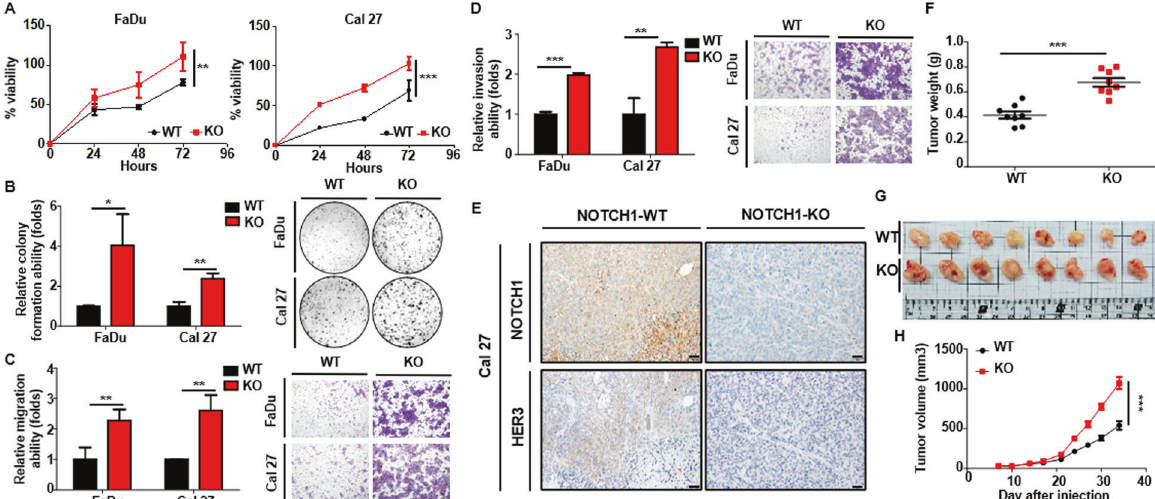
Fig. 4 Loss of function of NOTCH1 down-regulates HER3 expression and augments tumor aggressiveness in SCCHN. Functional assays were performed and a comparison between the NOTCH1-wild type (WT) and NOTCH1-knockout (KO) SCCHN cells. Knockout of NOTCH1 signi fi cantly promotes the cellular viability ( A ), the capability of colony formation ( B ), migration ( C ), and invasion ( D ) in both FaDu and Cal 27 cells. Data are presented as the mean ± SD. * p < 0.05; ** p < 0.01 and *** p < 0.001 ( E ) Immunohistochemical staining revealed that the expression of HER3 was positively correlated with NOTCH1 in the xenografted Cal 27 cells in the murine subcutaneous xenograft model. The tumor volumes ( F , G ) of the NOTCH1-knockout tumors are signi fi cantly increased compared to those of the NOTCH1-wild type tumors. Scale bar, 50 μ m. Data are presented as the mean ± SEM. *** p < 0.001.